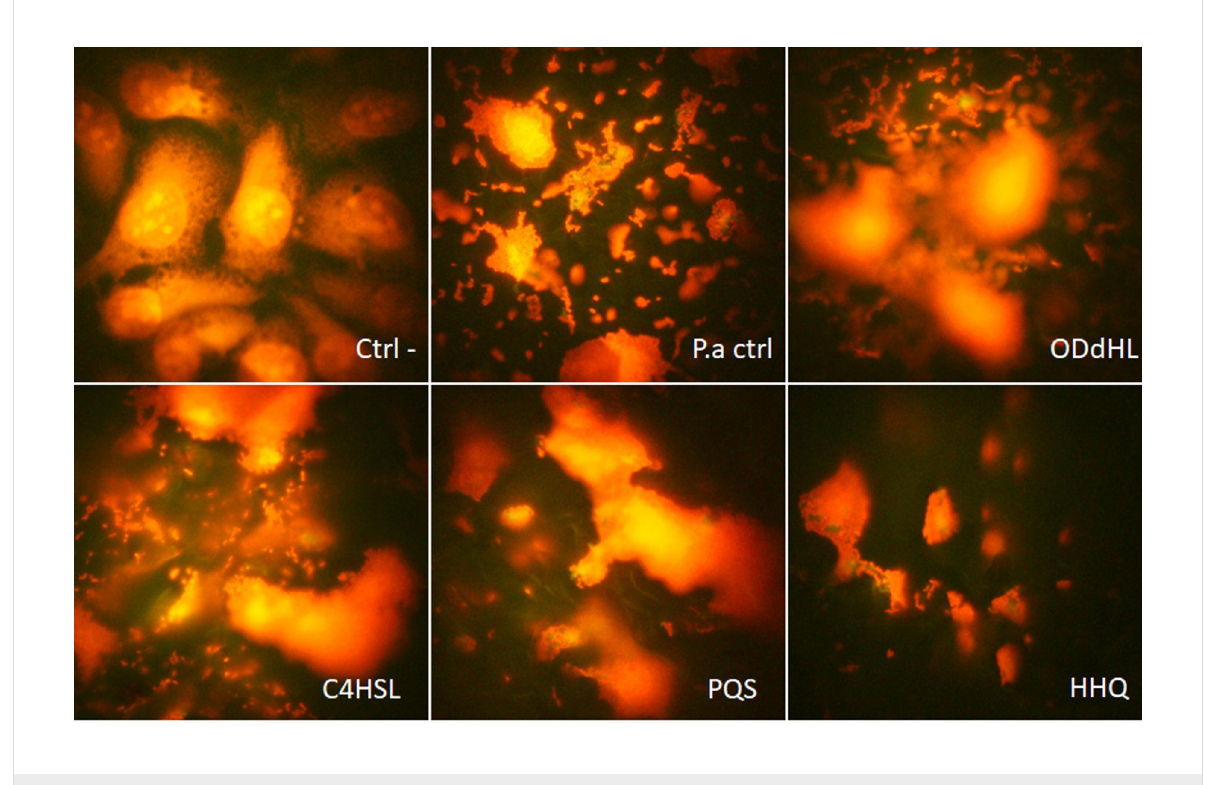
Figure 3: Fluorescence microscopy images of QSSMs treated euckariote cells, revealing attachment patterns. (Ctrl- = untreated control cells, P.a ctrl = P. aeruginosa control treated cells, ODdHL = P. aeruginosa + OddHL treated cells, C4HSL = P. aeruginosa + C4HSL treated cells, PQS = P. aeruginosa + PQS treated cells, HHQ = P. aeruginosa + HHQ treated cells, ob. 100×, immersion oil.